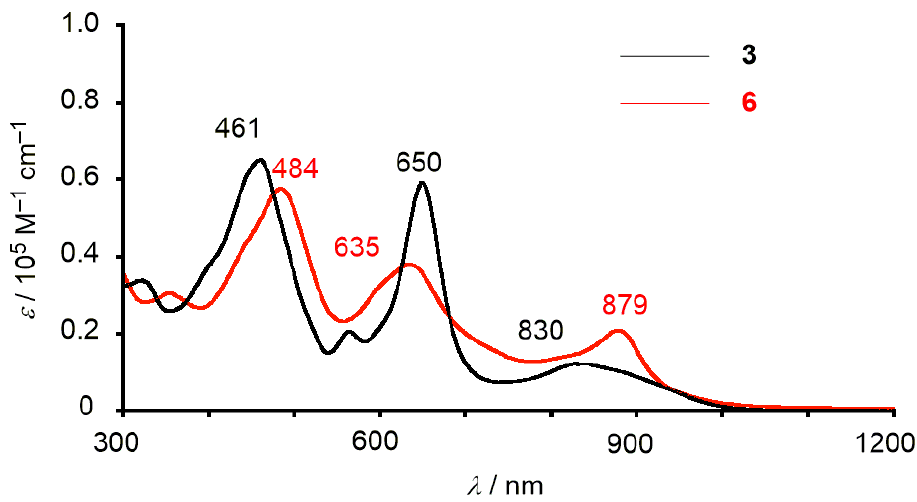
Figure 6. Absorption spectra of 3 (black) and 6 (red) in CH 2 Cl 2 .